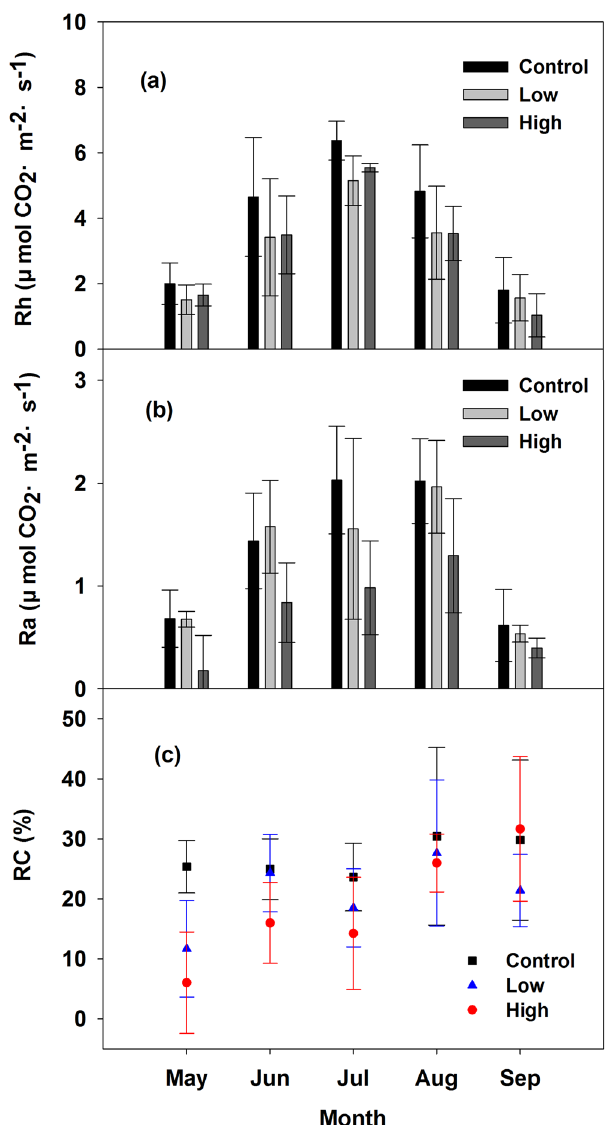
Figure 2. Seasonal variations of ( a ) the soil heterotrophic respiration rates ( R h), ( b ) the soil autotrophic respiration rates ( R a) and ( c ) the RC ( R a: R s) in the control, low, and high burning severity plots. The data were the average values in 2010, 2011, 2012. The error bars represent the standard